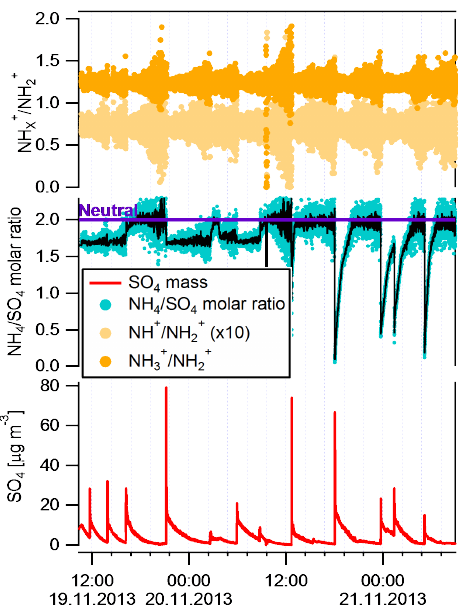
Figure 3. AMS measurements of SO 4 (red line) concentrations and NH 4 / SO 4 molar ratios (blue markers for raw data and black line for smoothed data). Also shown are the ratios between the main ammonium fragments, to inspect a possible interference from O + and HO + on the determination of NH 4